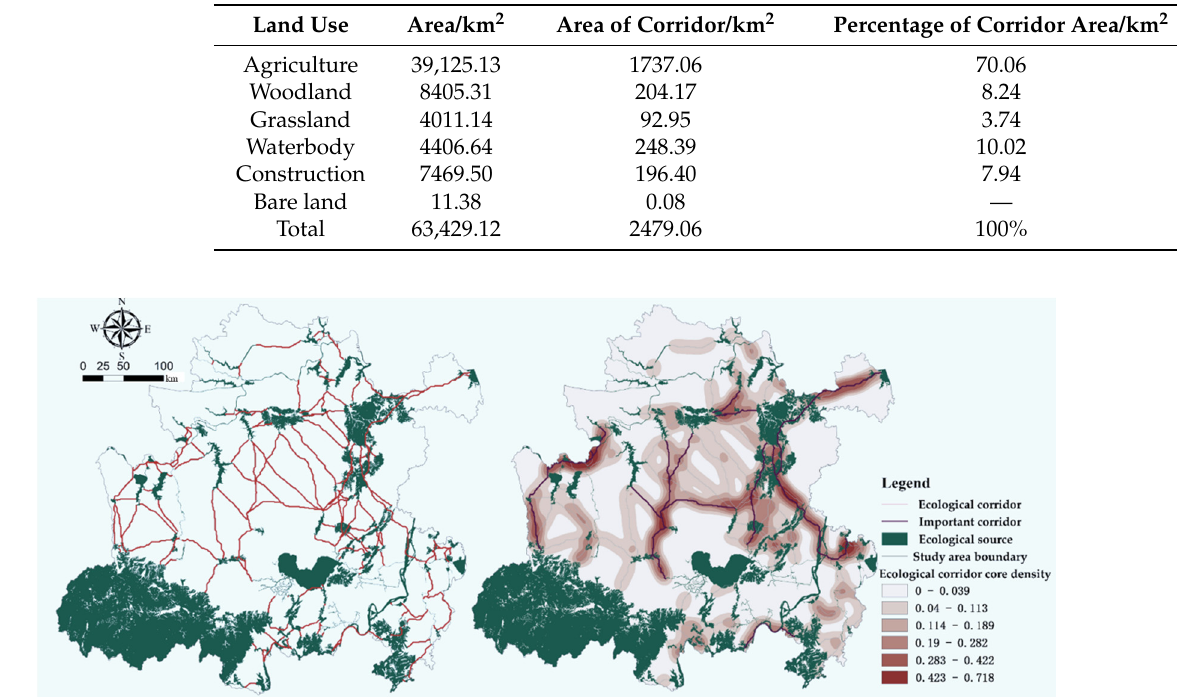
Table 4. Landscape composition of an ecological corridor.